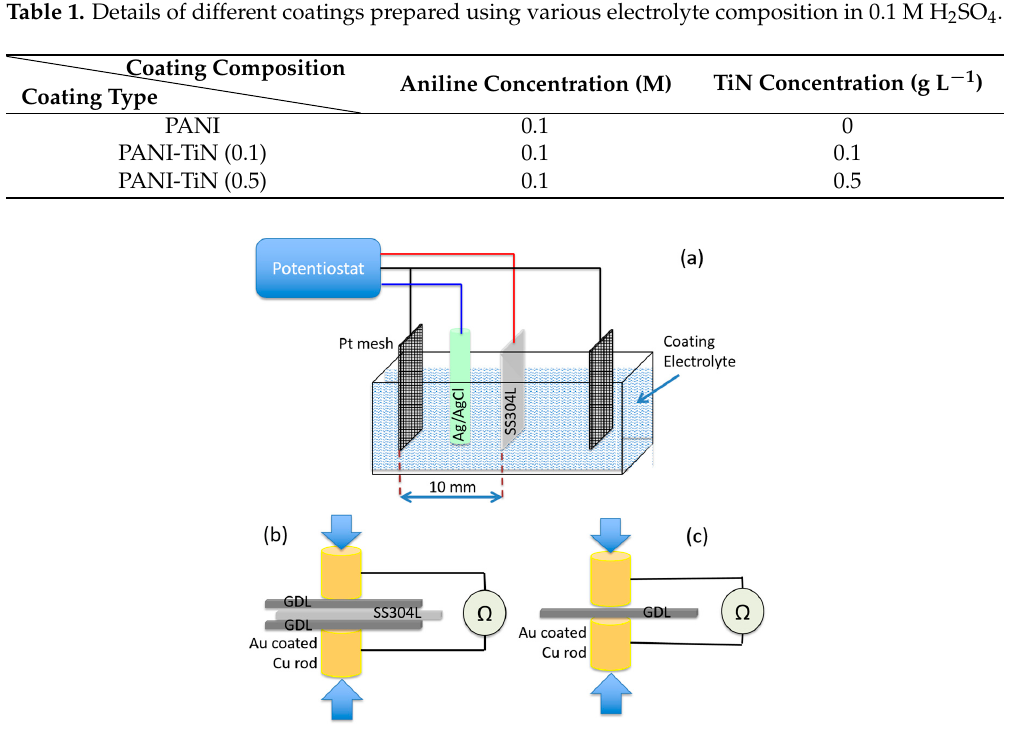
Figure 1. Schematic of ( a ) coating set up, ( b ) ICR measurement of SS coupon (ICR coupon+2xGDL ), and ( c ) ICR measurement of GDL (ICR GDL ). ( c ) ICR measurement of GDL (ICR GDL Table 1. Details of different coatings prepared using various electrolyte composition in 0.1 M H 2 SO 4 . Coating Composition